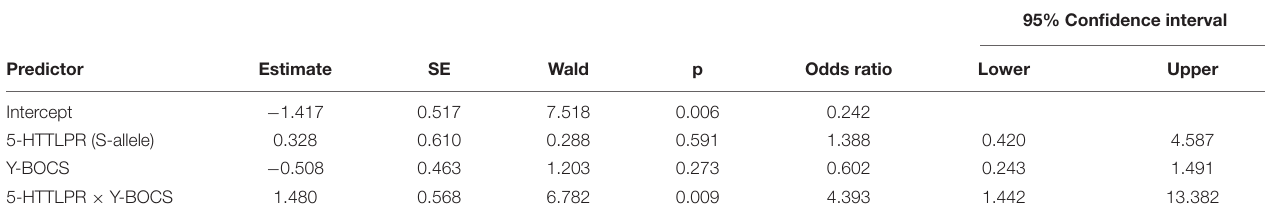
TABLE 2 | Logistic regression analysis predicting lifetime suicide attempt from 5-HTTLPR, chronic OCD symptoms, and the interaction between 5-HTTLPR and chronic OCD symptoms.